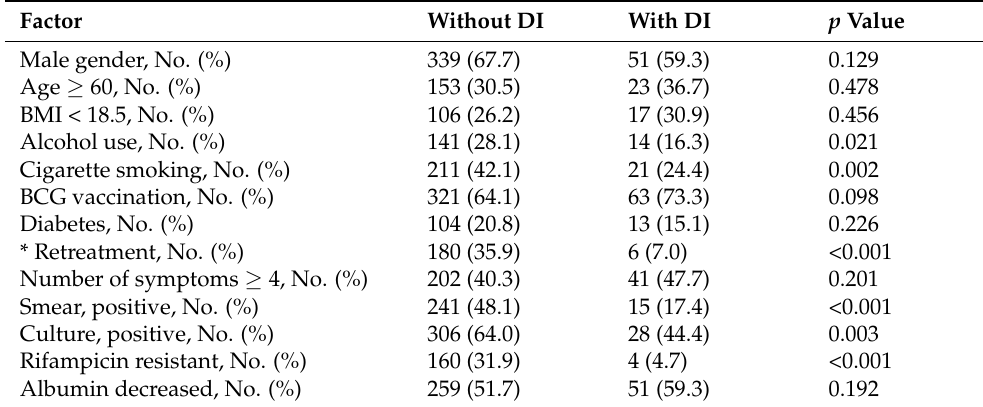
Table 2. Univariate analysis of DI in TB patients.